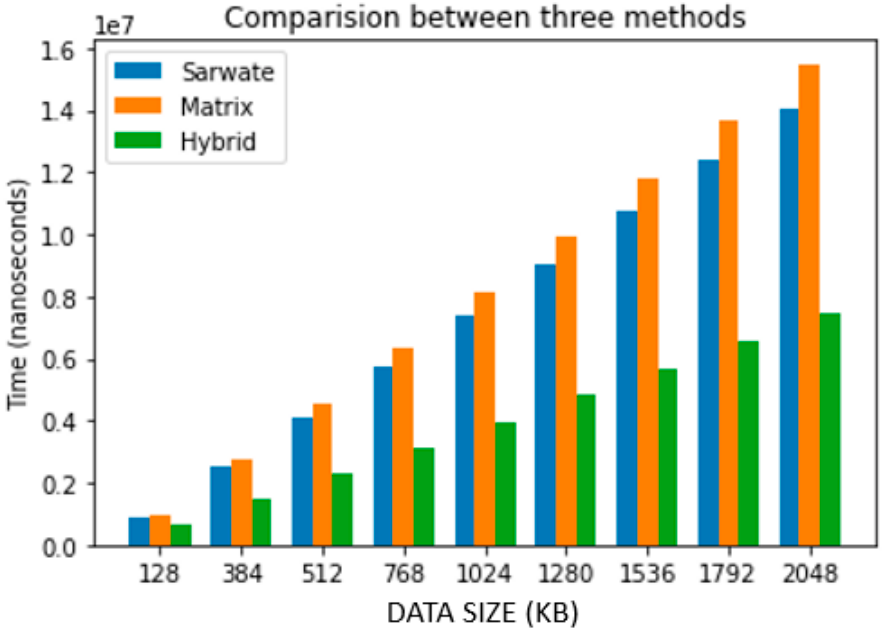
Figure 9. Comparison between three methods, hybrid methods running with two threads.